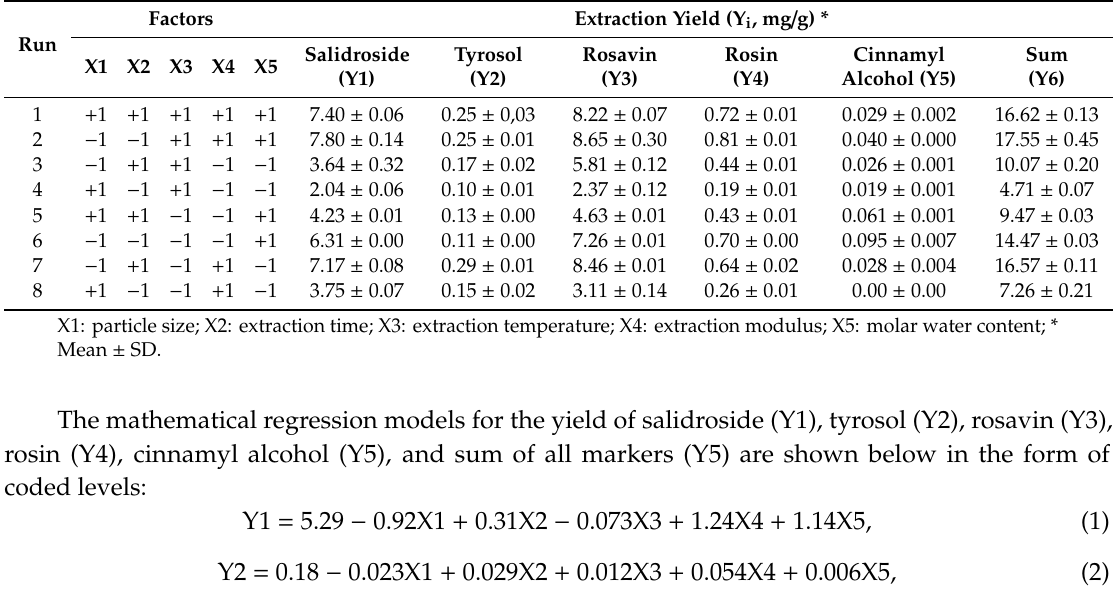
Table 3. Plackett–Burman experiment design with the independent